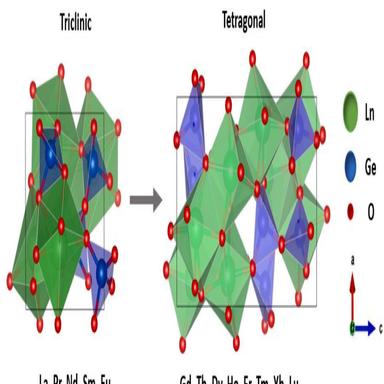
Schematic structures for the two Ln2Ge2O7 crystalline families under investigation: triclinic P1 space group, for Ln = La–Eu; and tetragonal P41212 space group, for Ln = Gd–Lu.